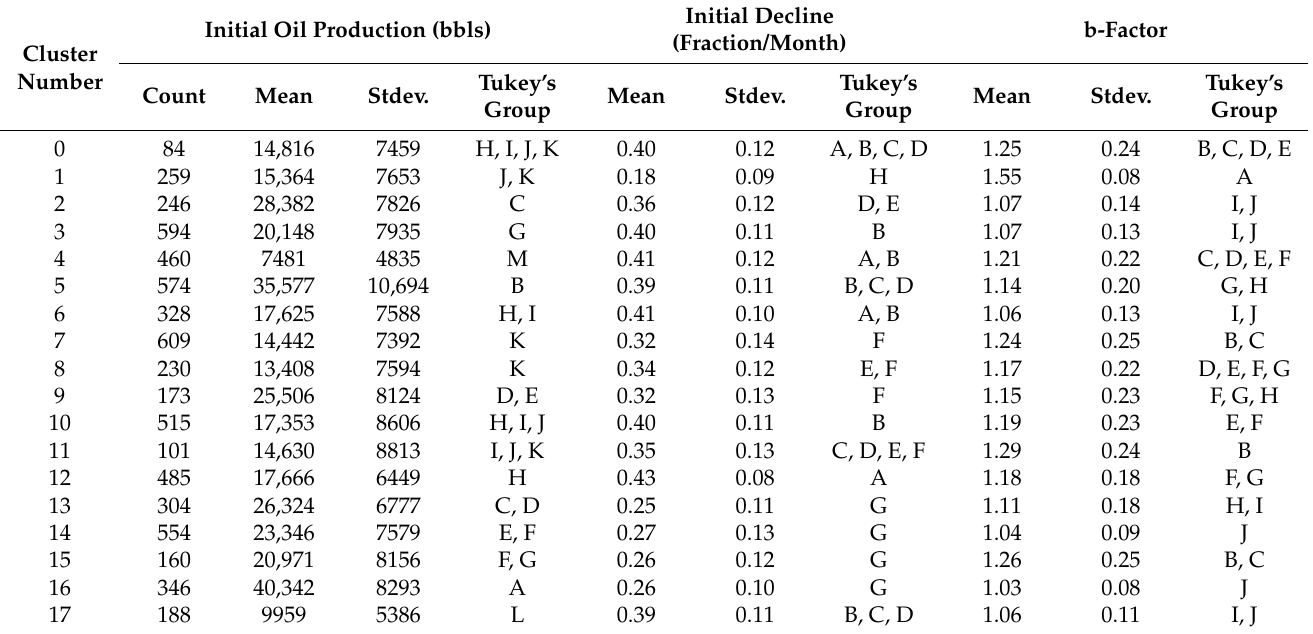
Table A1. Descriptive statistics and results from Tukey’s test on decline curve attributes across well clusters.